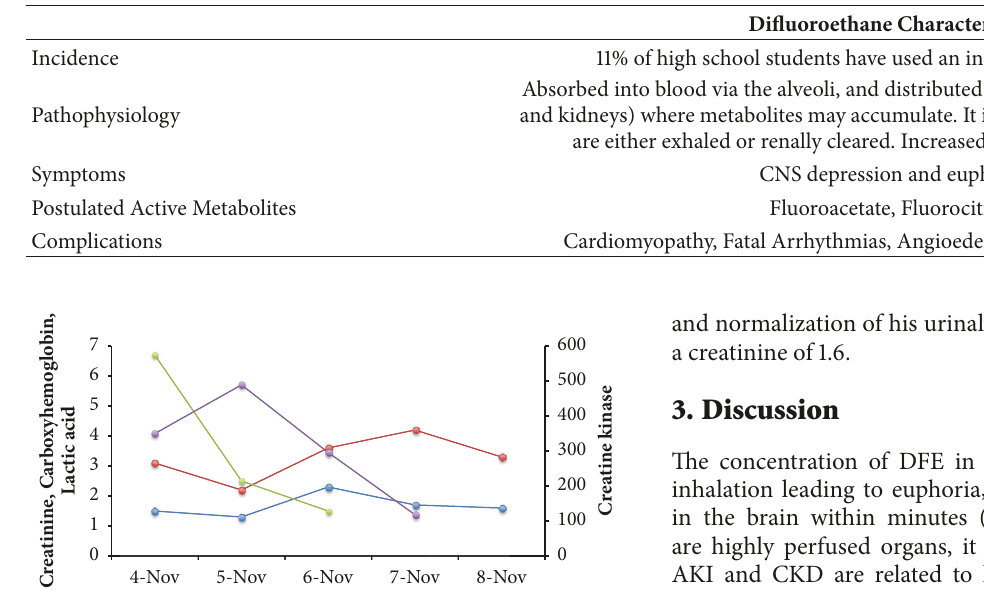
Table 1: Characteristics of difluoroethane [1, 10].